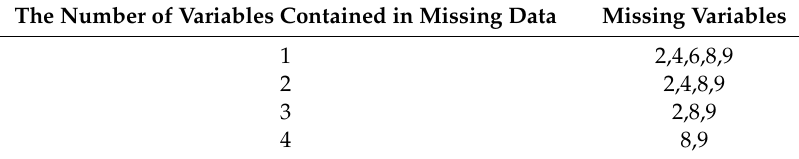
Table 4. Details of missing